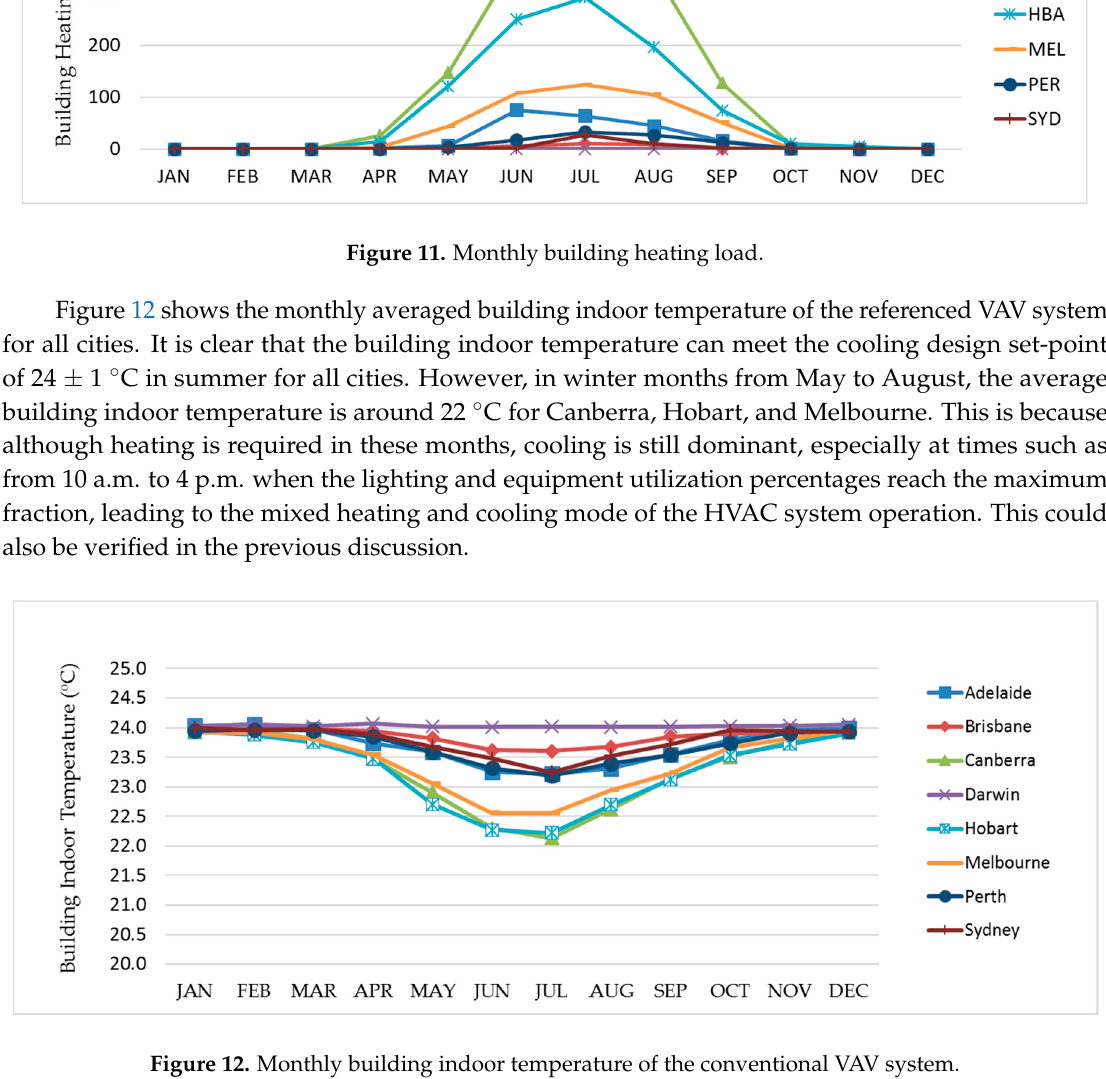
Figure 10. Monthly building cooling load.